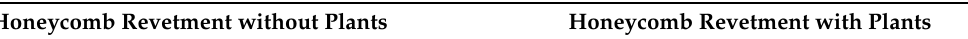
Table 3. Comparison between the per-width averaged wave overtopping of the experiments and that of the numerical simulation (Unit: m 3 /(m ·